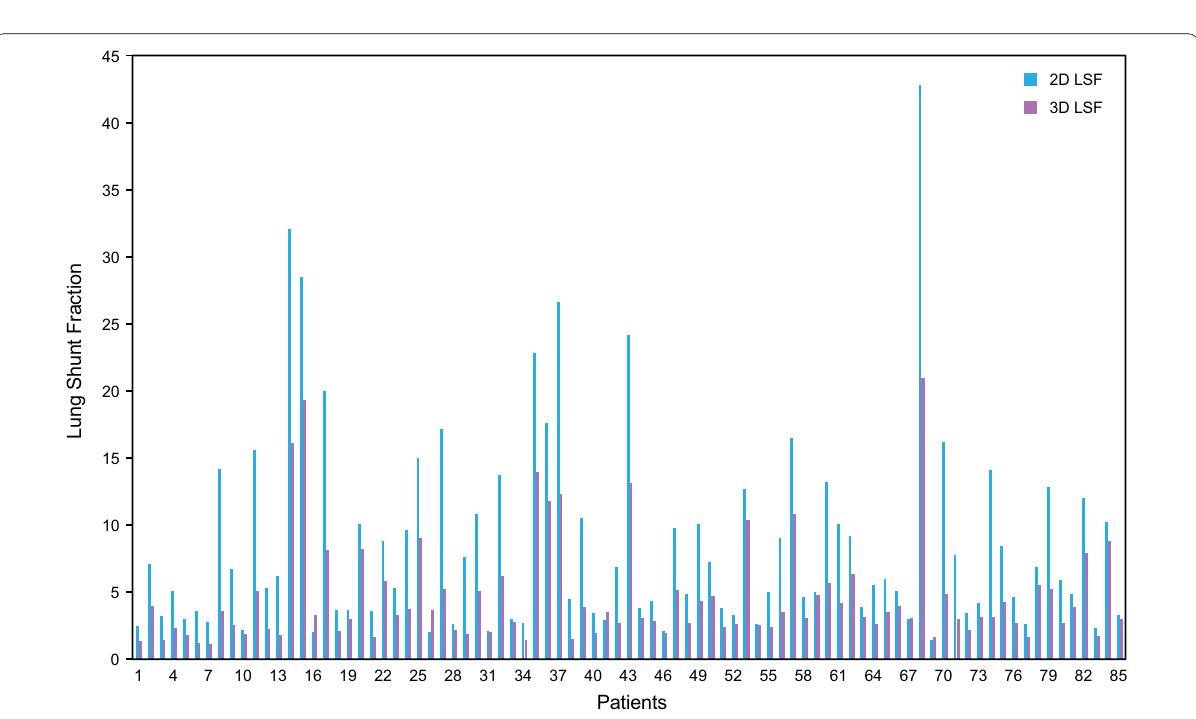
Fig. 1 Comparison of 99m Tc-MAA planar imaging LSF vs. SPECT/CT derived LSF in 85